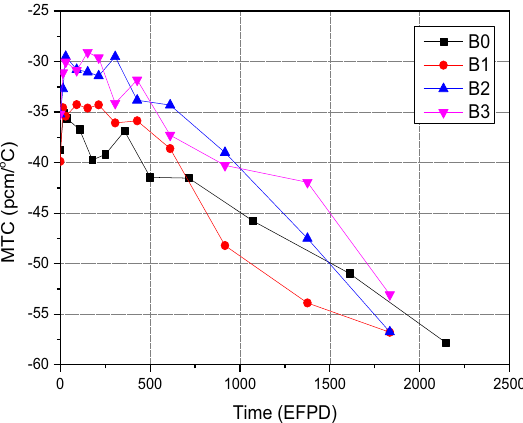
Figure 3. Comparison of the moderator temperature coefficients (MTC) of the fuel assemblies calculated by